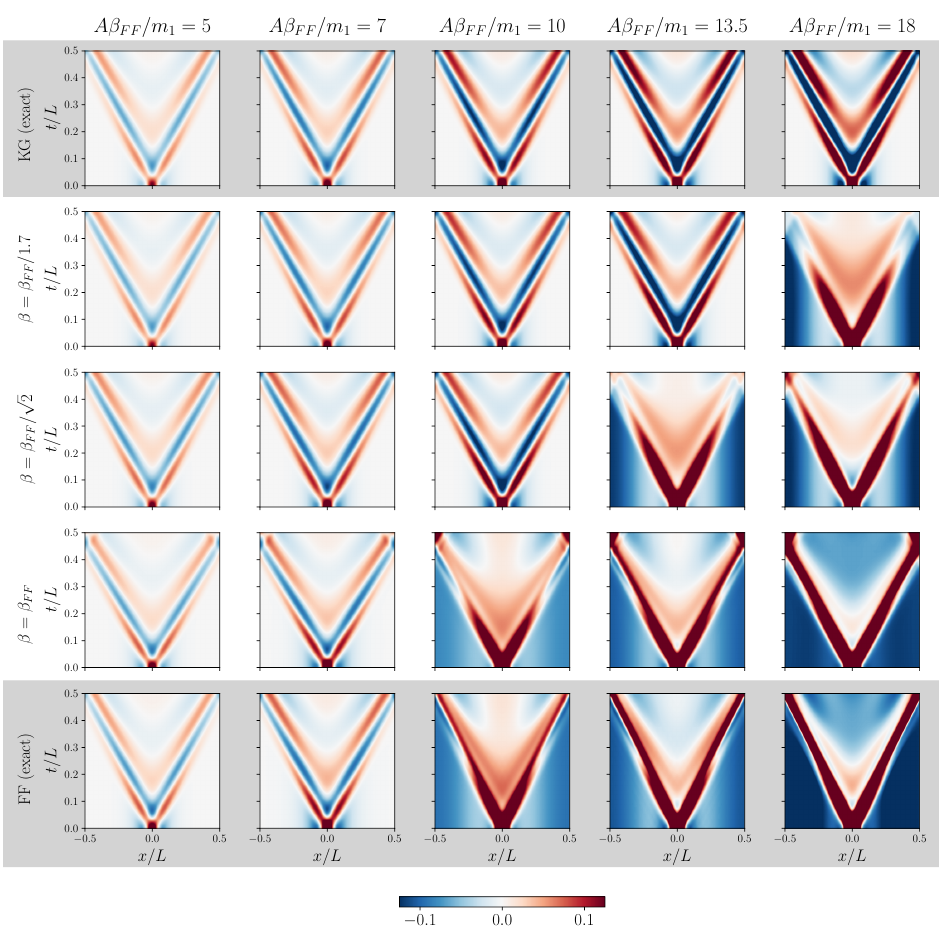
〈 ˆ ρ ( x , t ) 〉 Figure 4.9: Time evolved QFT expectation value m − 1 for five different amp- j 1 σ = 2 / 3. The interaction parameters litudes of the external field with bump-width m (cid:112) 1 / 1.7, β = β / are β = 0 (Klein–Gordon theory), β = β 2 and β = β . For the FF FF FF computation of the free fermion dynamics, both TCSA and the numerically exact 〈 ˆ ρ ( x , t ) 〉 method was used. For the Klein–Gordon case m − 1 was obtained by rescal- (cid:112) j 1 〈 ∂ π ) which corresponds to the β = β / 1.7 point ˆ ϕ ( x , t ) 〉 with 1 / ( 1.7 ing m − 1 x j FF 1 = 30 were shown in the row below. For the TCSA quantities, data with the cut-off e c used. (See the extrapolated version for TCSA in Appendix